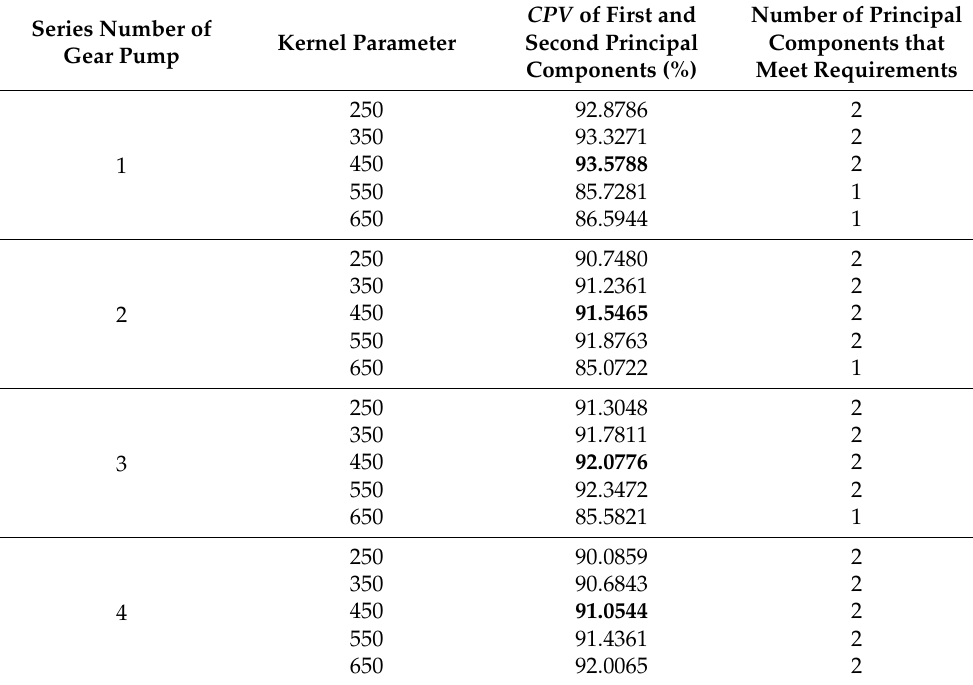
Table 5. CPV and number of kernel principal components corresponding to different kernel parameters. Series Number of